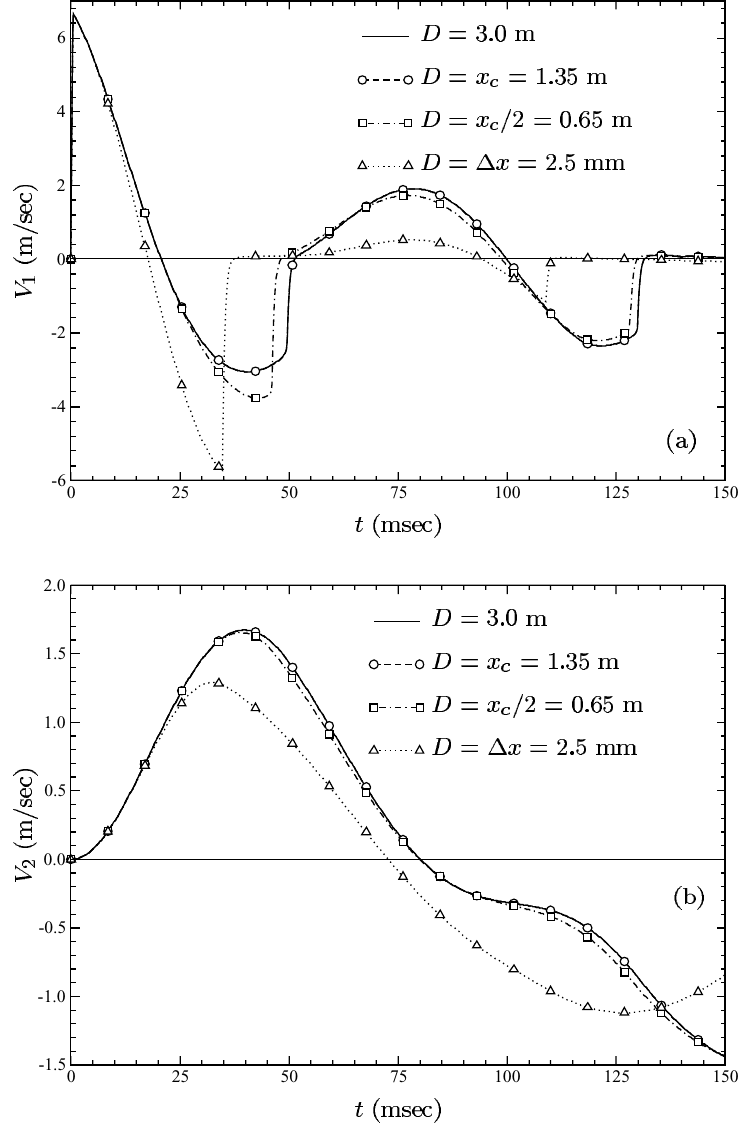
Fig. 9. (a) V 1 - and (b) V 2 -response histories for M 2 /M 1 = 5 , demonstrating the performance of truncated CAFE